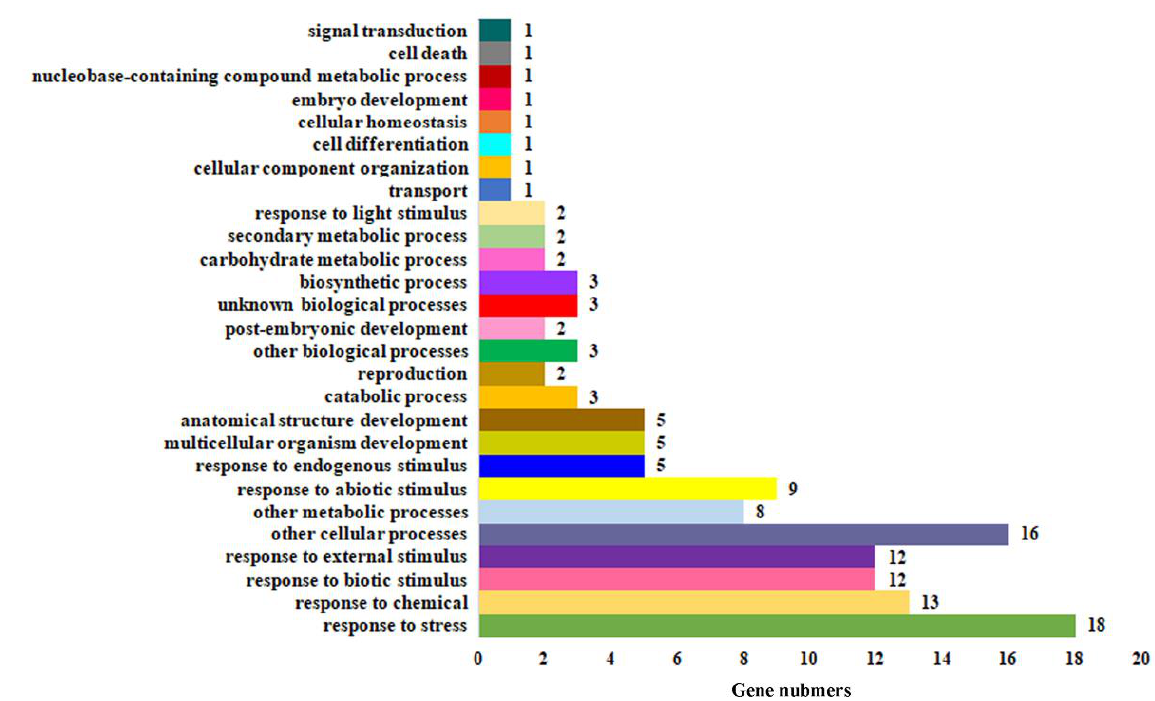
Figure 6. Functional categorization of the different expressed genes. The 26 genes up-regulated at least 2 folds in 35S:MYB71-GR transgenic plant treated with DEX were used for functional categorization annotation by using TAIR gene ontology (GO) annotation (https://www.arabidopsis.org/tools/bulk/go/index.jsp, accessed on 14 September 2021). The number of genes in different biological process was indicated.